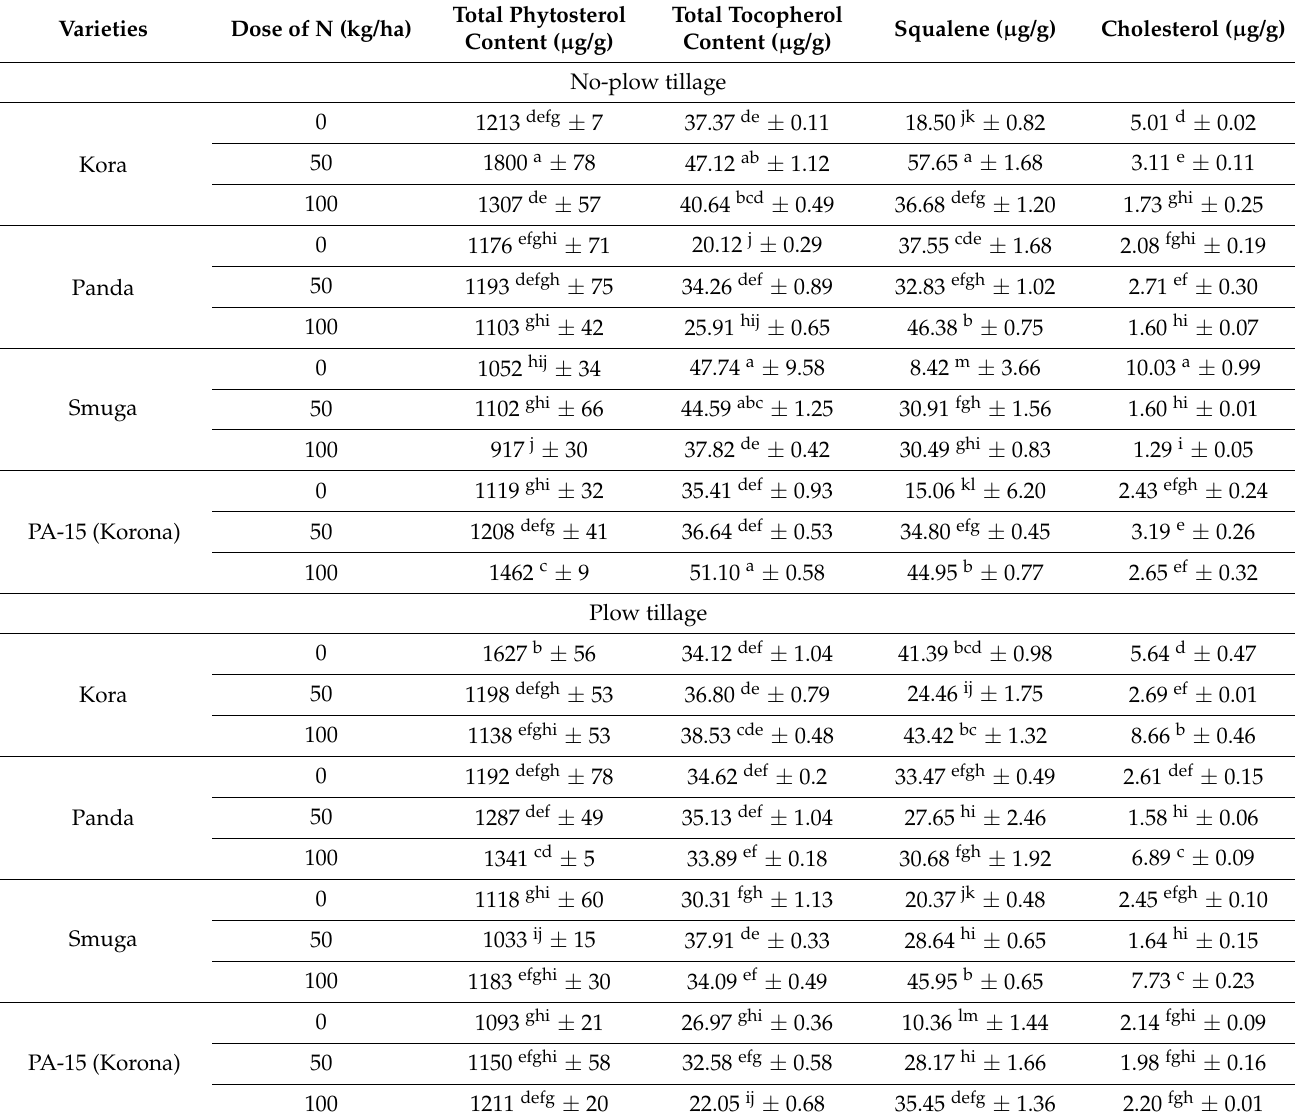
Table 1. Total phytosterol, tocopherol, squalene, and cholesterol content of four varieties of no-plow tillage and plow tillage common buckwheat, by fertilization